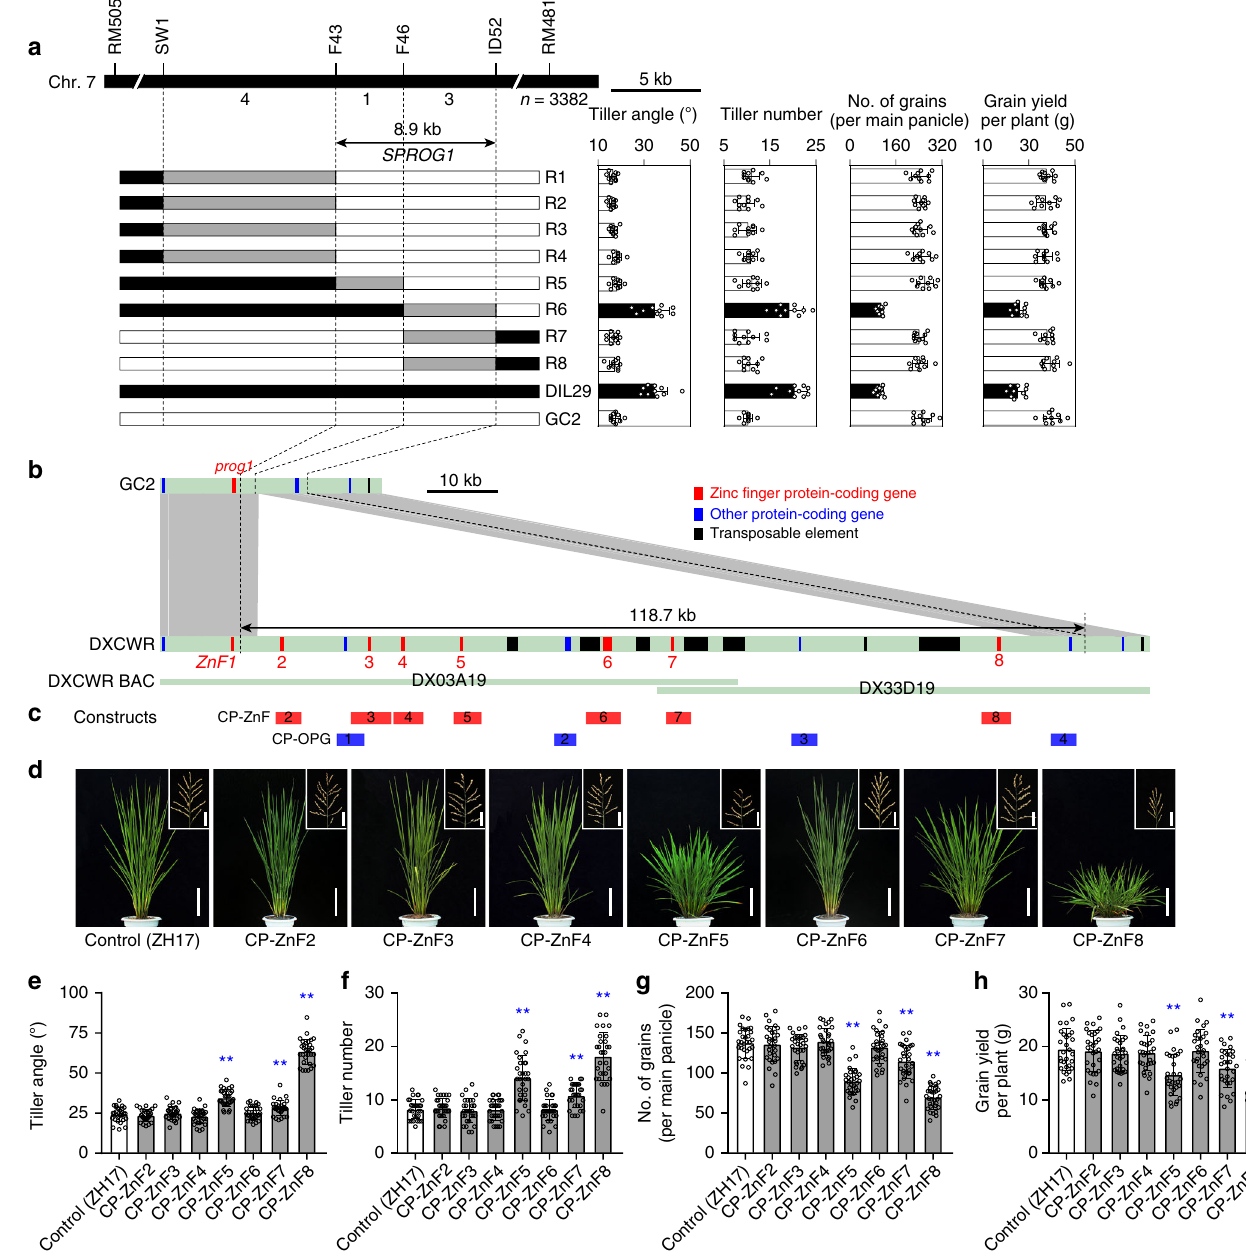
Fig. 2 Map-based cloning of SPROG1 . a SPROG1 was delimited to an 8.9 kb region between the F43 and ID52 markers by evaluating the phenotypes of homozygous recombinants (R1 through R8). Numbers below the bar indicate the number of recombinants between the two adjacent markers. In graphical genotypes of recombinants, the black, white, and gray regions represent homozygous for the DXCWR genome, homozygous for GC2 genome, and the interval in chromosome where crossover took place, respectively. Data are means ( n = 10), with error bars showing standard deviation. b Comparison of genomic sequence and gene annotation between GC2 and DXCWR in the fi ne-mapping region of SPROG1 . The red, blue, and black boxes respectively indicate zinc- fi nger protein-coding genes, other protein-coding genes, and transposable elements. The gray shading represents the regions sharing sequence collinearity between GC2 and DXCWR genomic sequences. c The location of the sequences included in the 11 complementary constructs (CP- ZnF2 through CP-ZnF8 and CP-OPG1 through CP-OPG4). d Phenotypes of the transgenic plants of seven zinc- fi nger genes ( ZnF2 – ZnF8 ) and the control plant (ZH17). Scale bars, 20 cm (plant) and 5 cm (panicle). e – h Comparison of the tiller angle, tiller number, number of grains on the main panicle, and grain yield per plant between transgenic plants of seven zinc- fi nger genes ( ZnF2 – ZnF8 ) and the control plant (ZH17). Data are means ( n = 30), with error bars showing standard deviation. Two-tailed Student ’ s t tests were performed between ZH17 and transgenic plants ( ** P <